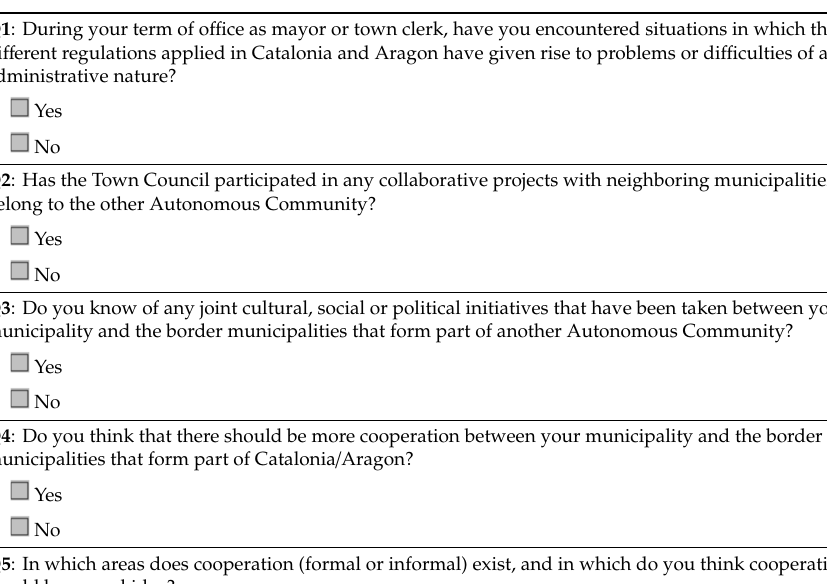
Table 6. Answers obtained in Q4 (source: authors). Q4: Do you think that there should be more cooperation between your municipality and the border municipalities that form part of Catalonia/Aragon? Responses